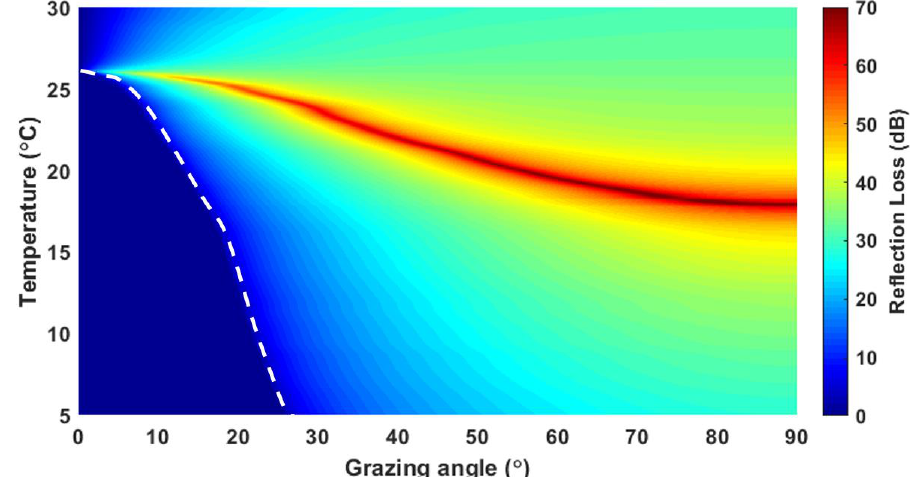
Figure 7. Reflection-loss simulation as functions of grazing angle and temperature for the water-castor oil interface. White dashed line represents the curves corresponding to critical angles, which varies with temperature and grazing angle. Red area corresponds to the area where the total transmissions occur.